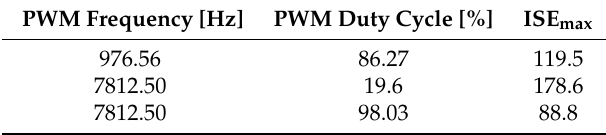
Figure 11. The ISE performance indexes incurred from the data in Figures 9 and 10, respectively. Table 1. The remainder of the experimental